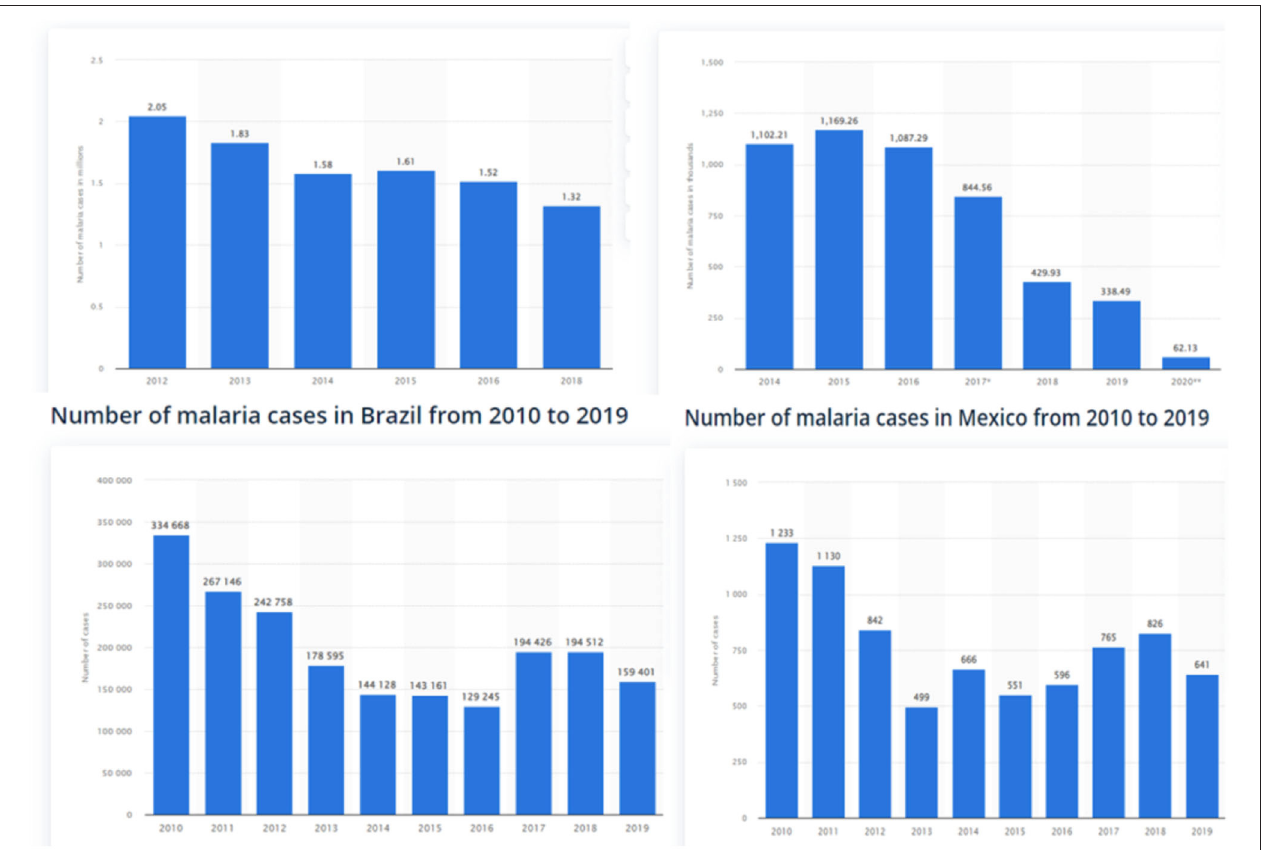
FIGURE 1 | Number of malaria cases per year in Indonesia, India, Brazil, and Mexico Source: Statista